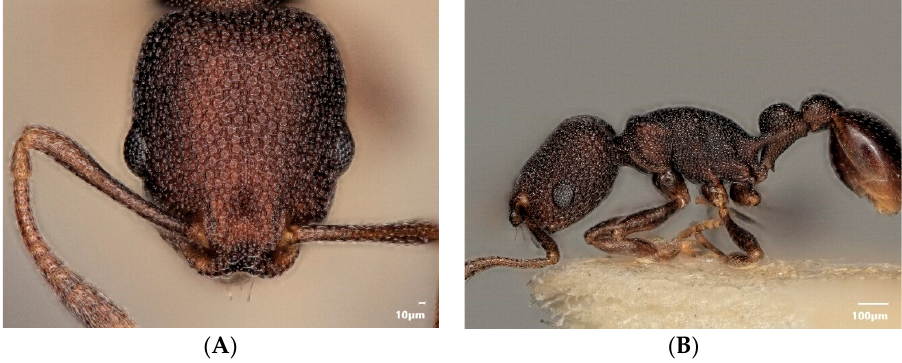
Figure 12. Cardiocondyla argyrotricha n.sp. holotype: head in dorsal view( A ), lateral view ( B ), dorsal view ( C ), waist in lateral view ( D ).